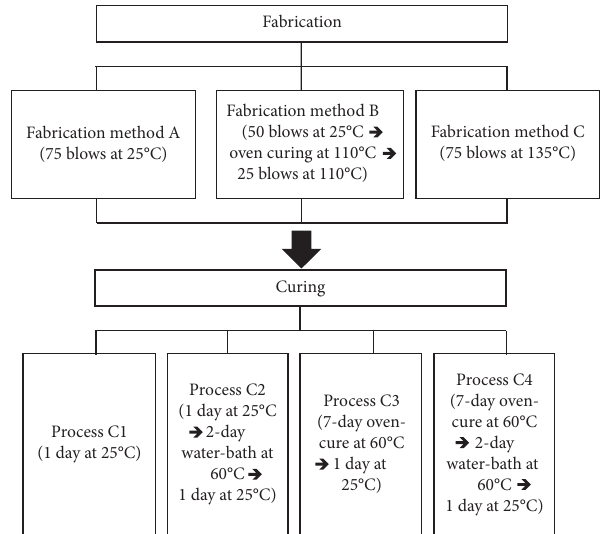
Figure 2: Flowchart of sample fabrication and the curing